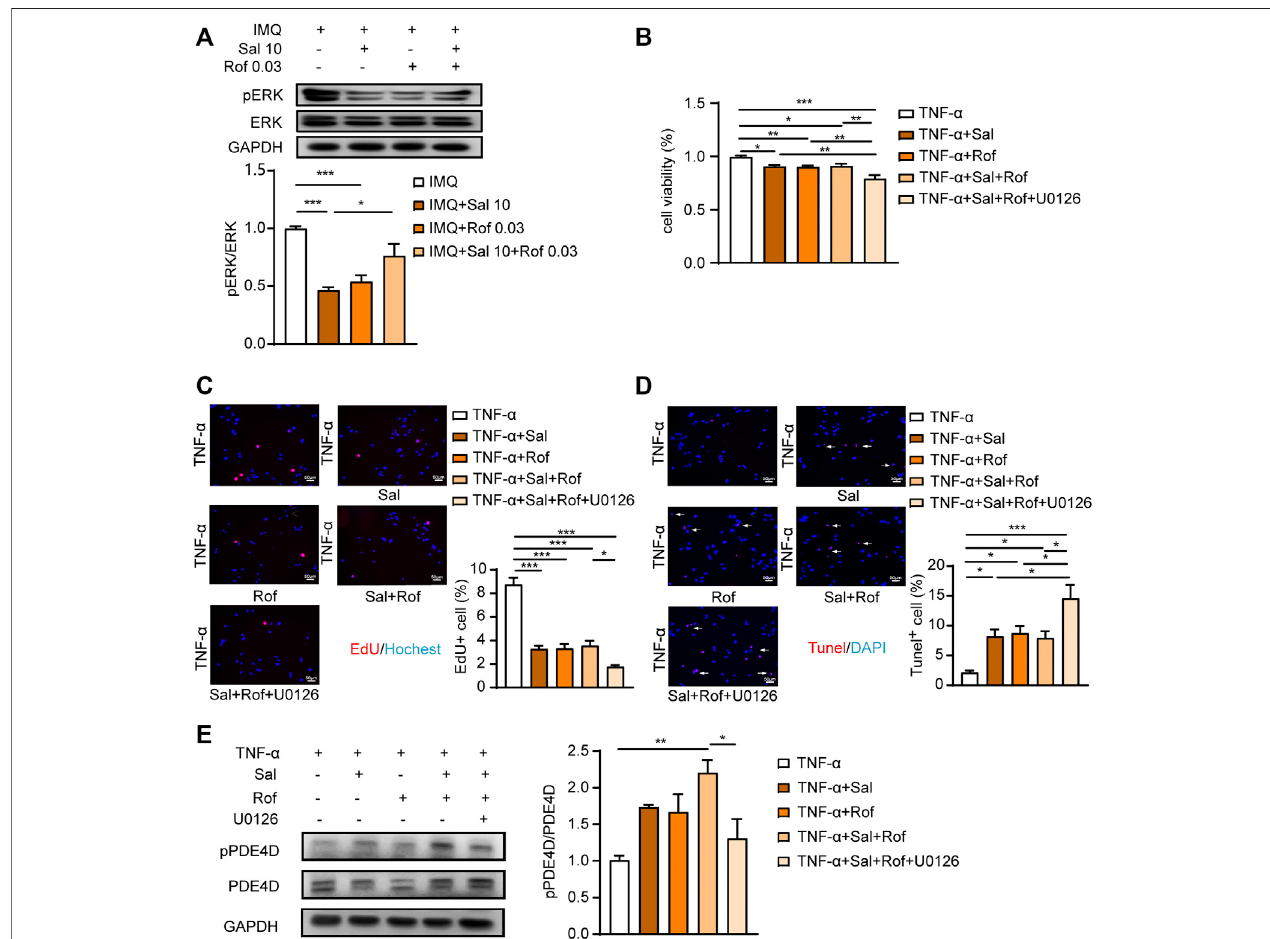
FIGURE 7 | ERK activation in the combination treatment mediates the lack of synergisms. (A) Psoriasis-like dermatitis was induced by IMQ in mice. Sal, Rof, and the combination of Sal and Rof were subcutaneously administered under the skin for 5 days. Expression levels of pERK and ERK in the back skin were detected by Western blotting. GAPDH served as the loading control ( n = 4). (B – D) HaCaT cells were serum starved overnight. During the experiment, HaCaT cells were cultured without serum. HaCaT cells were pretreated with U0126 (1 μ M), for 30 min followed by treatment with Sal (100 nM, 1 h) or Rof (100 nM, 30 min). The cells were then exposed to TNF- α (10 ng/ml) for 48 h ( n = 3). (B) Cell viability was measured by a CCK8 assay. (C) Cell proliferation was measured by EdU incorporation (×200, Scale bar = 50 μ m). (D) Cell apoptosis was measured by a TUNEL assay (×200, Scale bar = 50 μ m). (E) HaCaT cells were serum starved overnight. During the experiment, HaCaT cells were cultured without serum. HaCaT cells were pretreated with U0126 (1 μ M), for 30 min followed by treatment with Sal (100 nM, 1 h) or Rof (100 nM,30 min).ThecellswerethenexposedtoTNF- α (10 ng/ml)for1 h( n =3).ExpressionlevelsofpPDE4DandPDE4DweredetectedbyWesternblotting.GAPDH served as the loading control. Data are presented as the mean ± SEM. * p < 0.05, ** p < 0.01, and *** p < 0.001 by one-way ANOVA followed by Tukey ’ s post-hoc test.